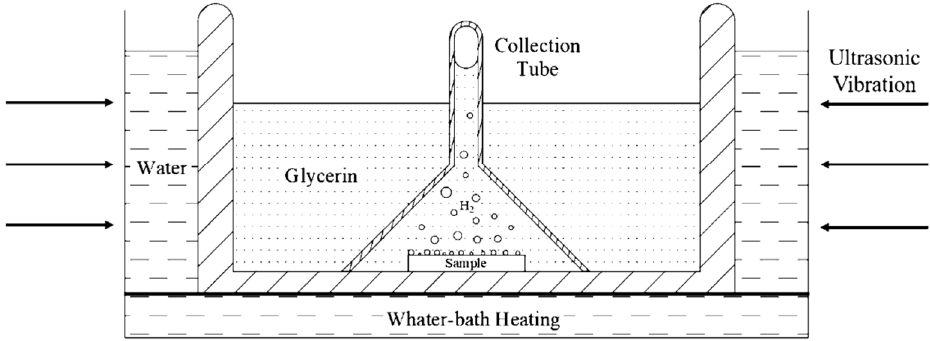
Figure 4. Schematic diagram of glycerin gas collecting and water-bath heating device.